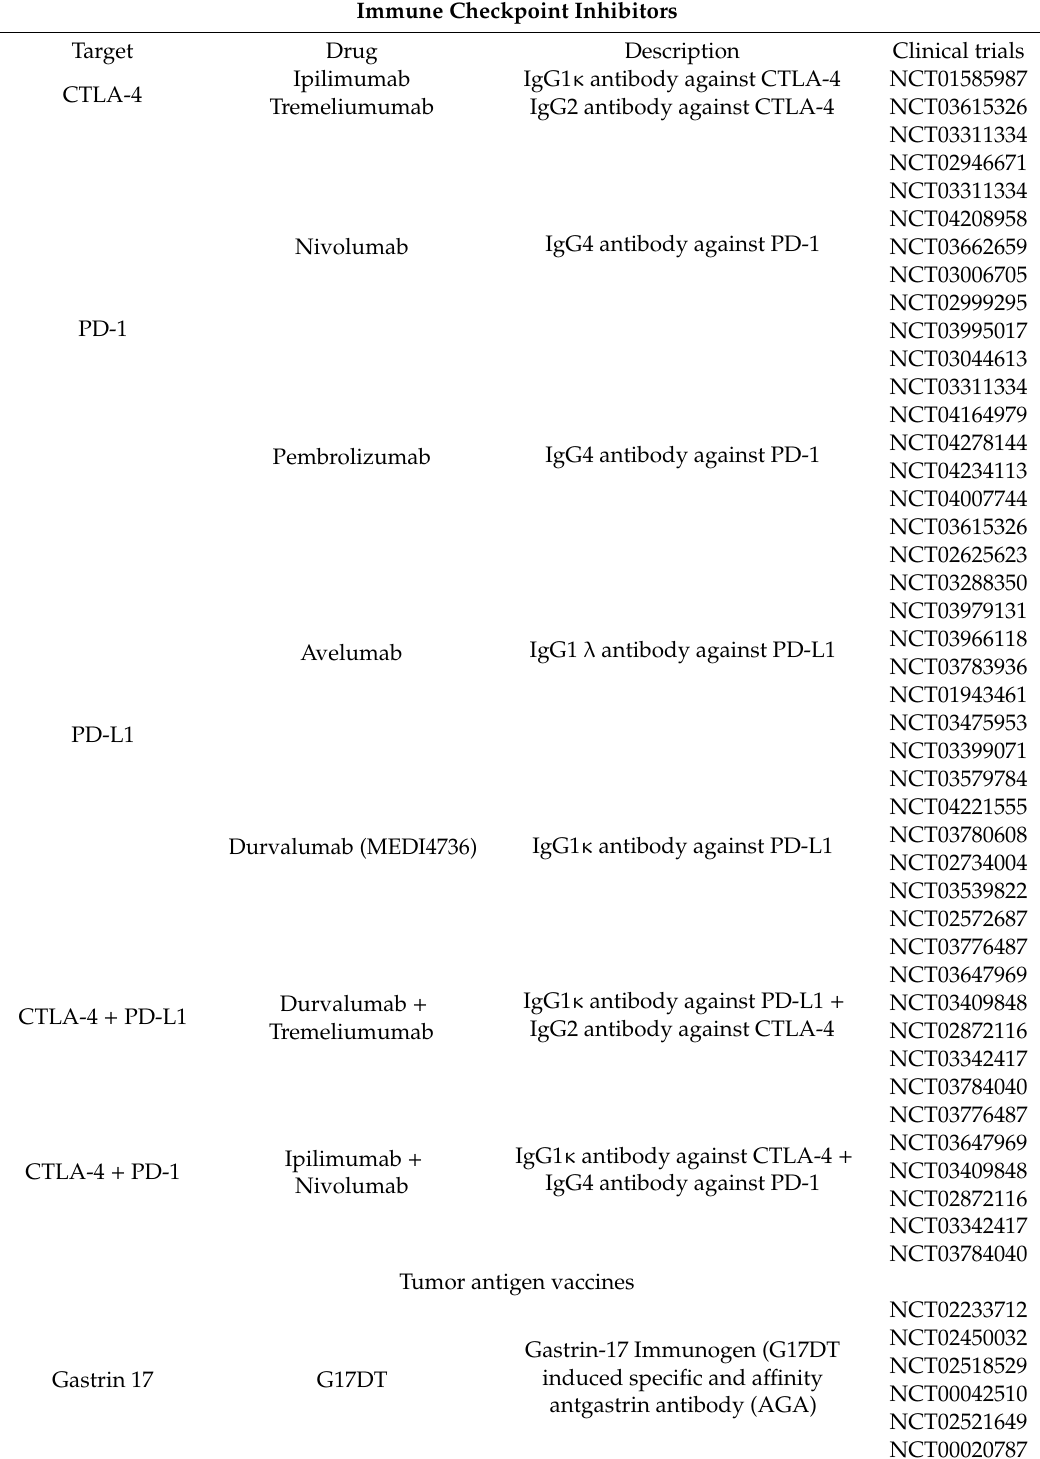
Table 1. Immunotherapies used in gastric